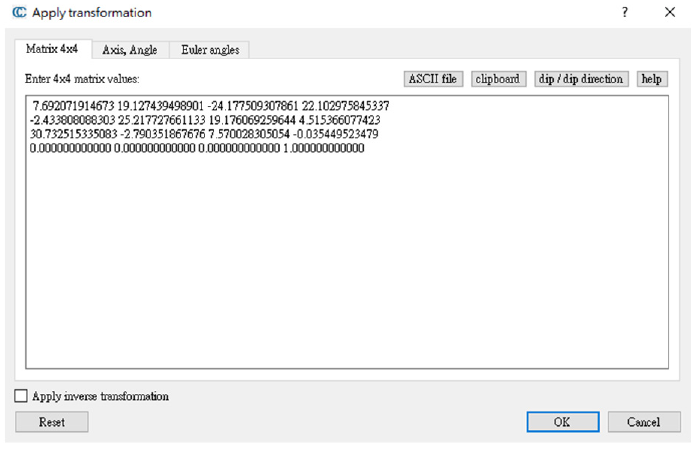
Figure 9. Schematic of conversion parameters.